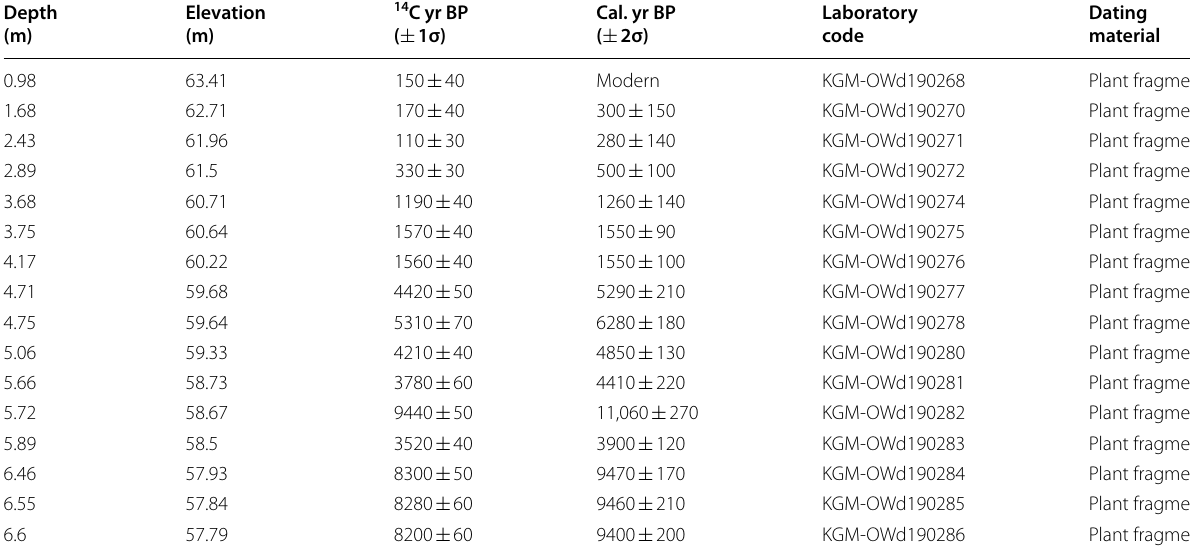
Table 1 Accelerator mass spectrometer 14 C dating and calibrated ages for core GG19‑01 sediment samples